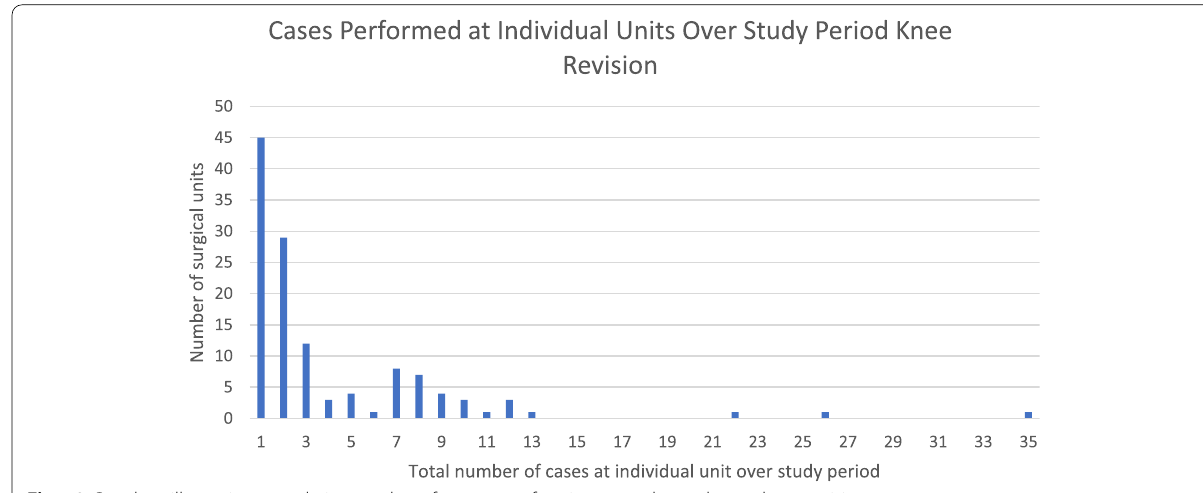
Fig. 10 Bar chart illustrating cumulative number of centers performing procedure volumes, knee